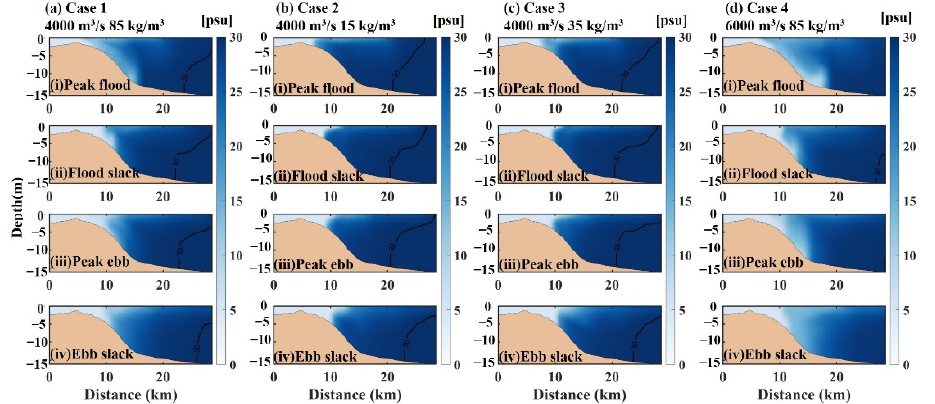
Figure 12. Vertical profiles of salinity along the axial section P1 at different times: Note that Figures